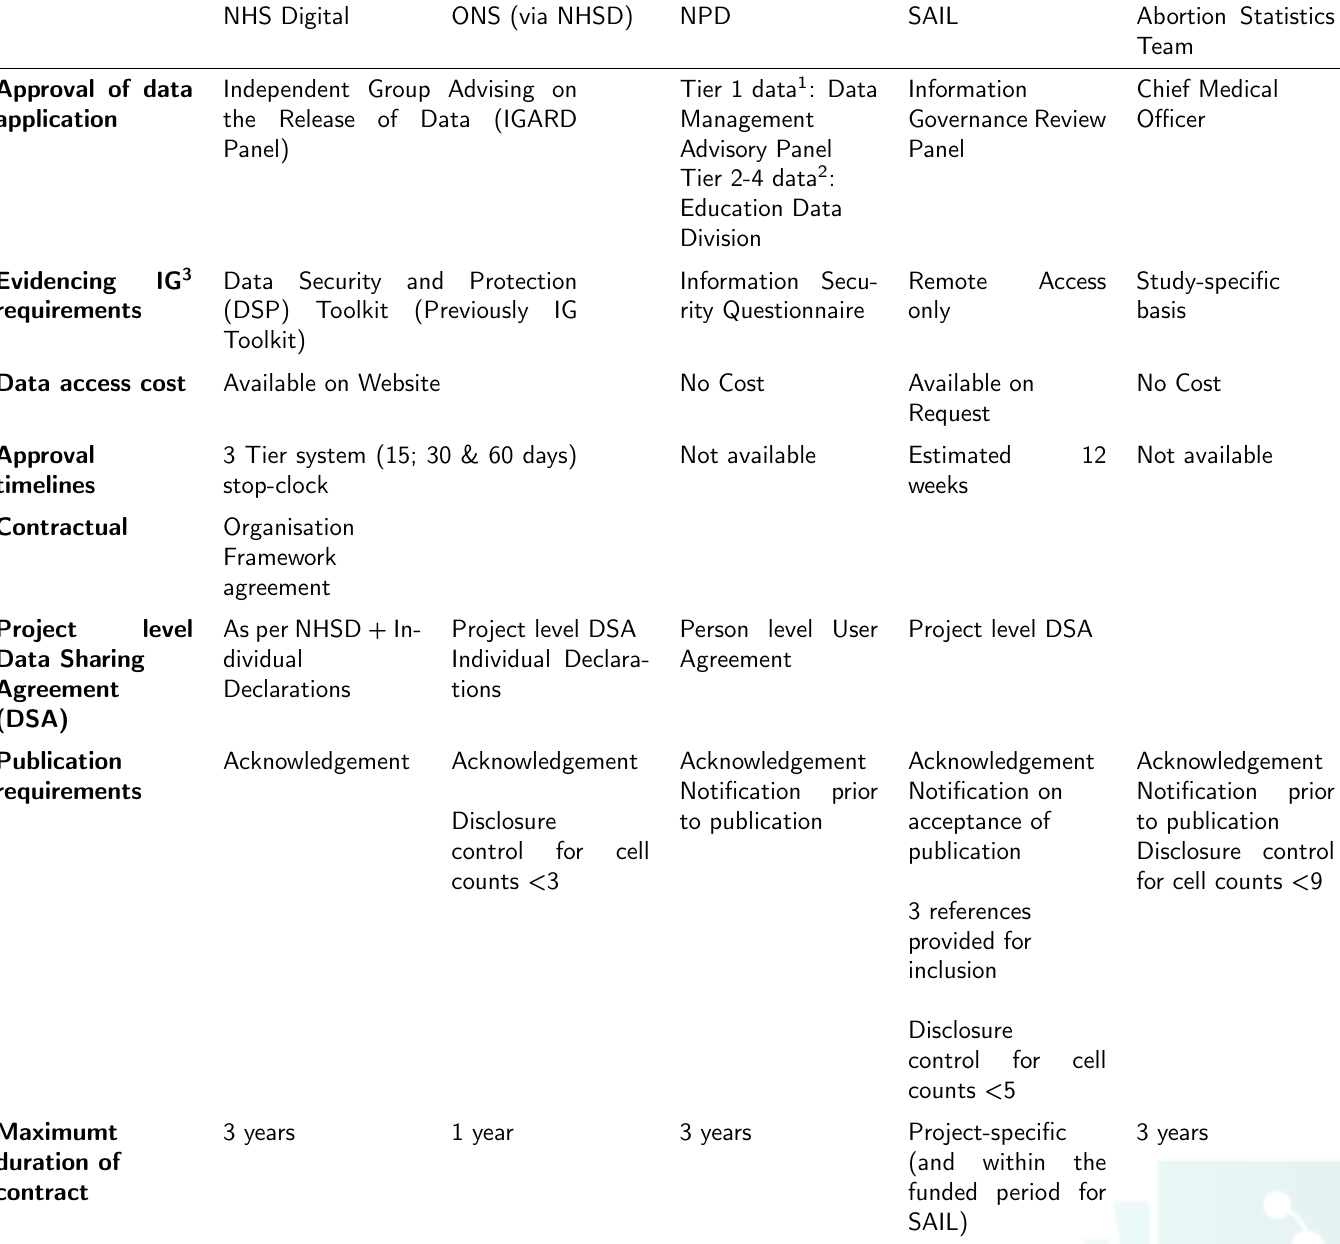
Table 2: Overview of the relevant Data